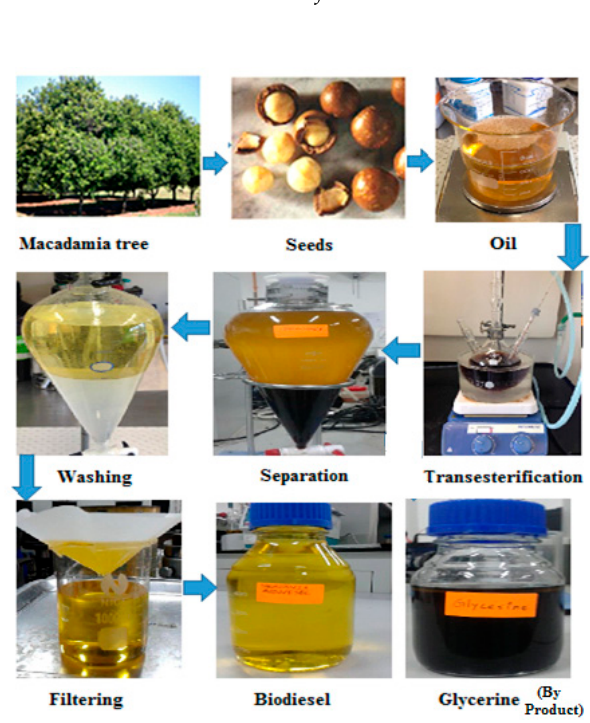
Figure 1. Production of macadamia biodiesel.